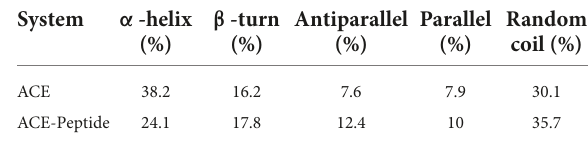
TABLE 4 Secondary structure change of ACE with peptide analyzed by